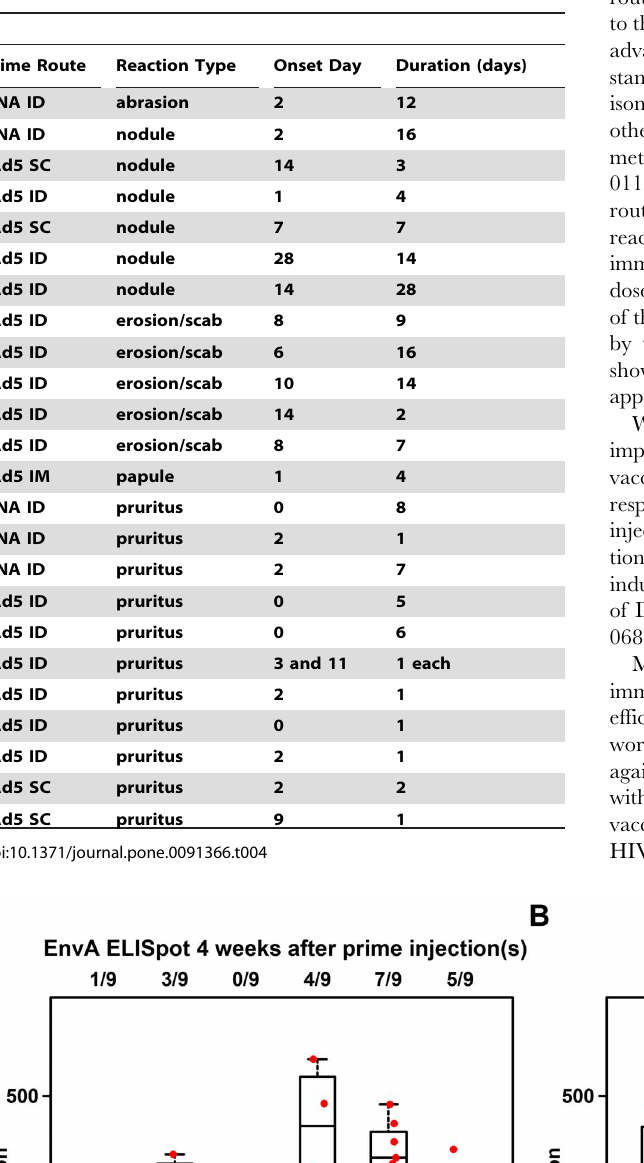
Table 4. Listing of Unsolicited Local Reactions After Prime Injections.